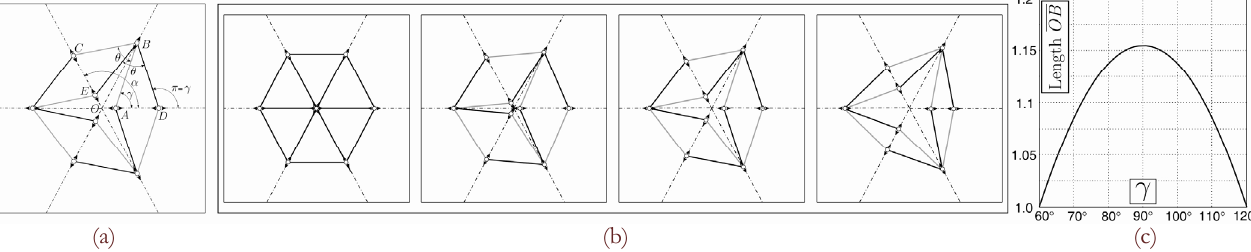
Figure 2: (a) Radially foldable structure with geometric parameters. (b) Configurations of the single degree of freedom lattices at different values of the geometrical parameter. (c) The radial distance OB as a function of γ is also given for p=1.